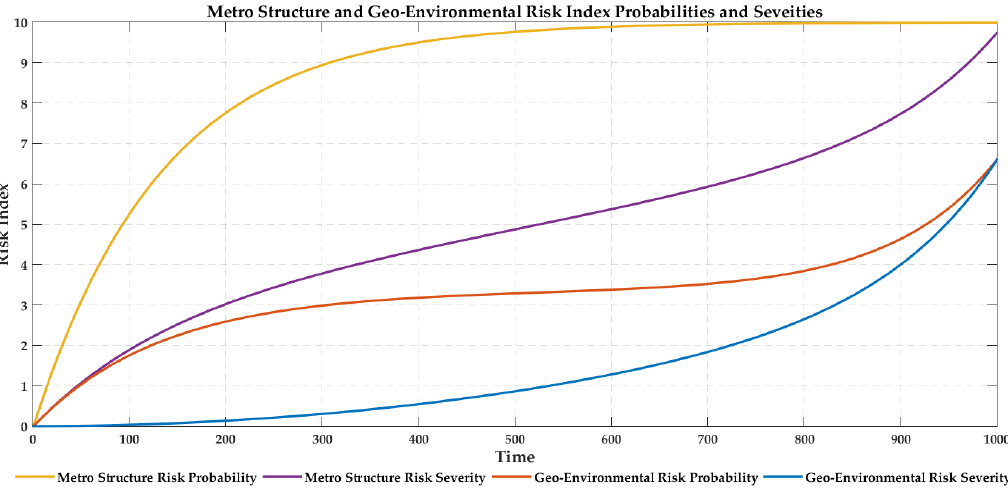
Figure 17. Data generated through different functions for Metro structure and geo-environmental risk probabilities and severities.